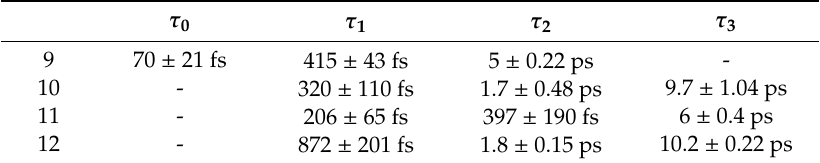
Figure 17. TAS displayed as false colour maps for molecules 9–12, respectively, in methanol photoexcited at ( a ) 306 nm, ( b ) 330 nm, ( c ) 341 nm and ( d ) 353 nm, studied by Losantos et al. [84]. Reproduced and adapted from [84], with permission from the PCCP Owner Societies. Table 4. Summary of time constants resulting from the global fit of the TAS of molecules 9–12 in methanol studied by Losantos et al. [84]. Reproduced and adapted from [84], with permission from the PCCP Owner